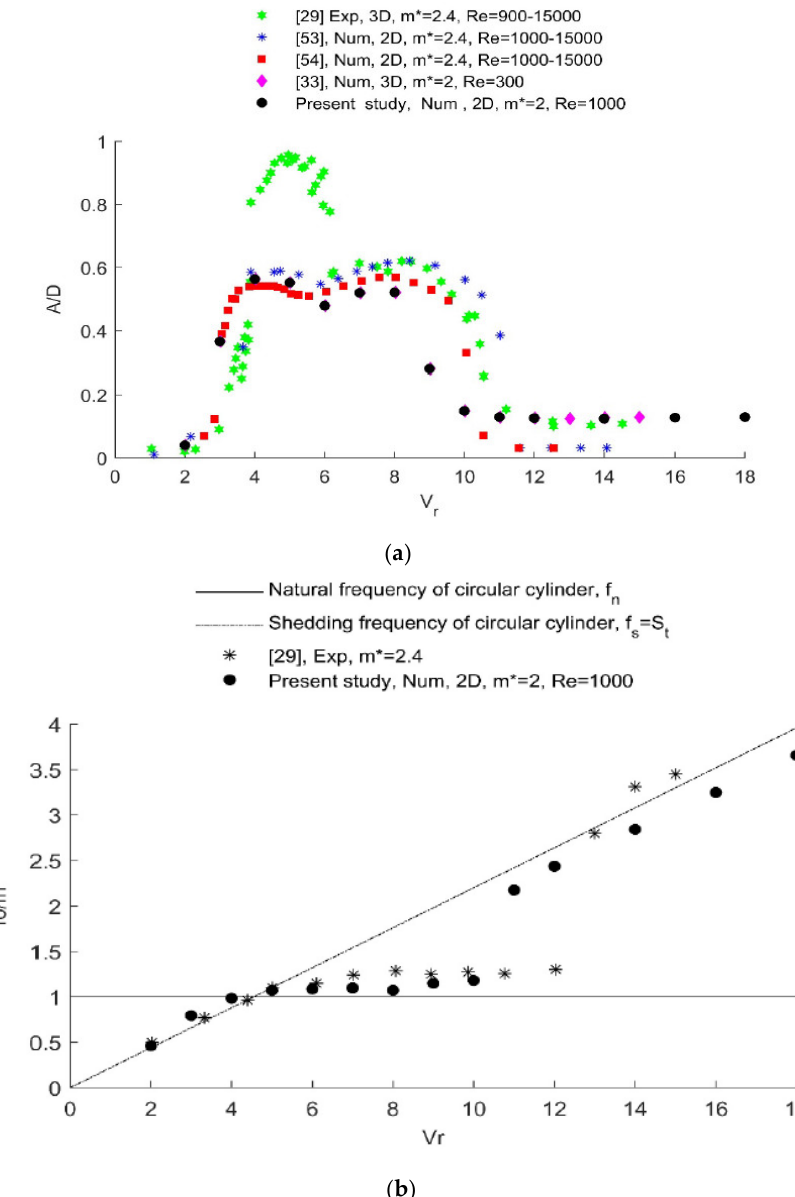
Figure 2. The VIV response of a circular cylinder, comparison between the current and published results, showing: ( a ) Normalized vibration amplitude vs. reduced velocity, and ( b ) normalized frequency vs. reduced velocity.